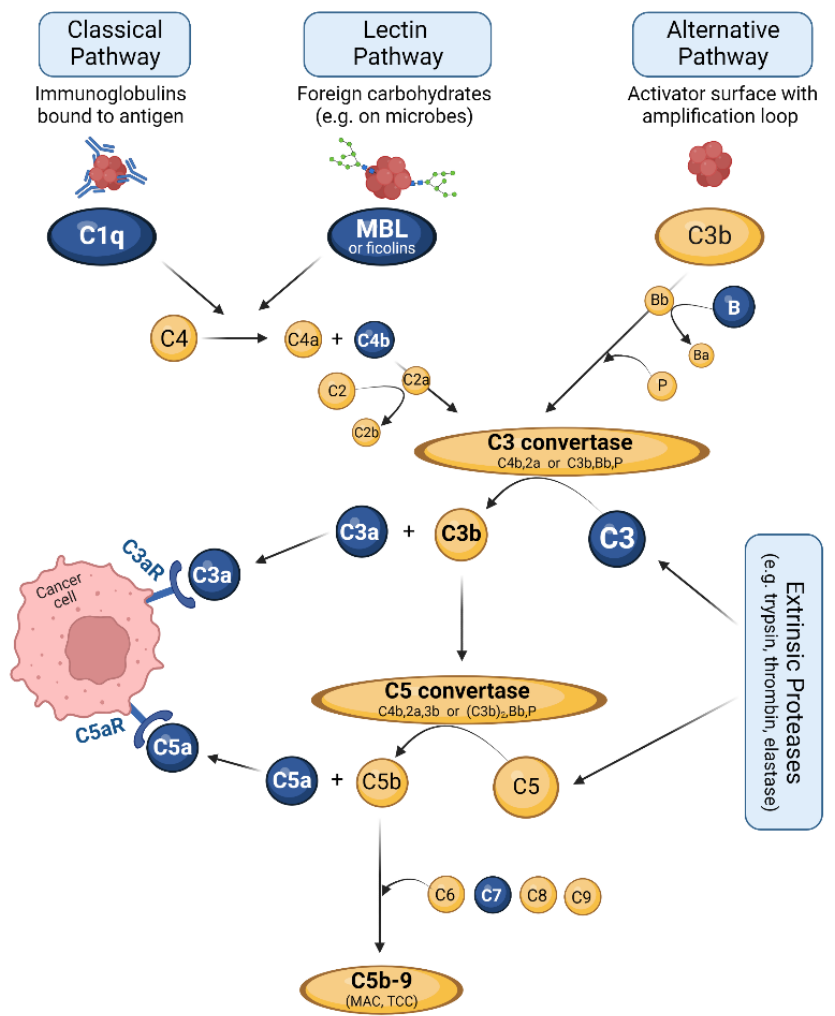
Figure 1. Overview of the three complement activation pathways and the subsequent cascade resulting in formation of the C5b-9 complex. Complement factors described as relevant for PDAC are labelled in blue. For further details, see text. MAC: membrane attack complex; TCC: terminal complement complex. Figure created with BioRender.com.